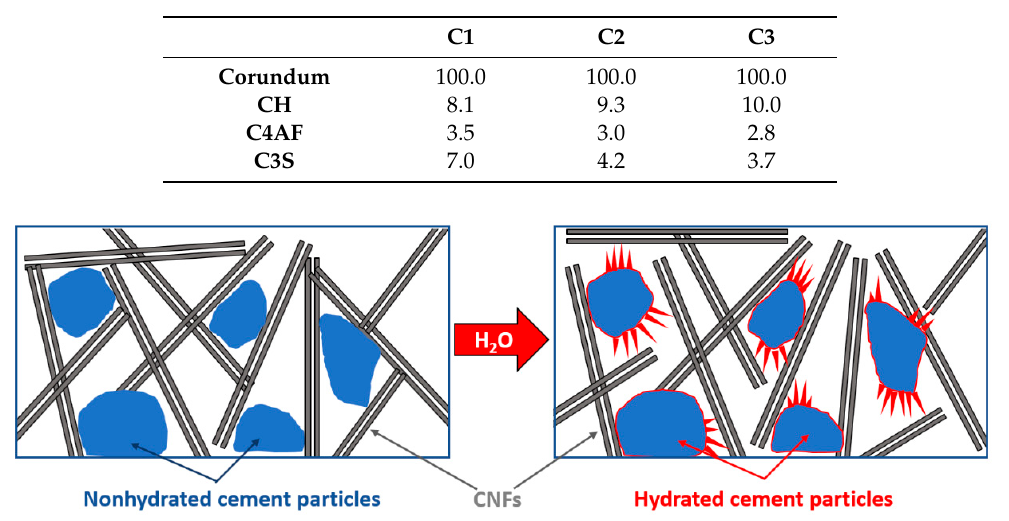
Figure 10. Schematic illustration of mechanism explaining increase in resistivity with increased water to cement ratio. The non-hydrated cement particles react with water. The hydration products (calcium silicate hydrate, calcium hydroxide) contribute to separation between conductive fibers.